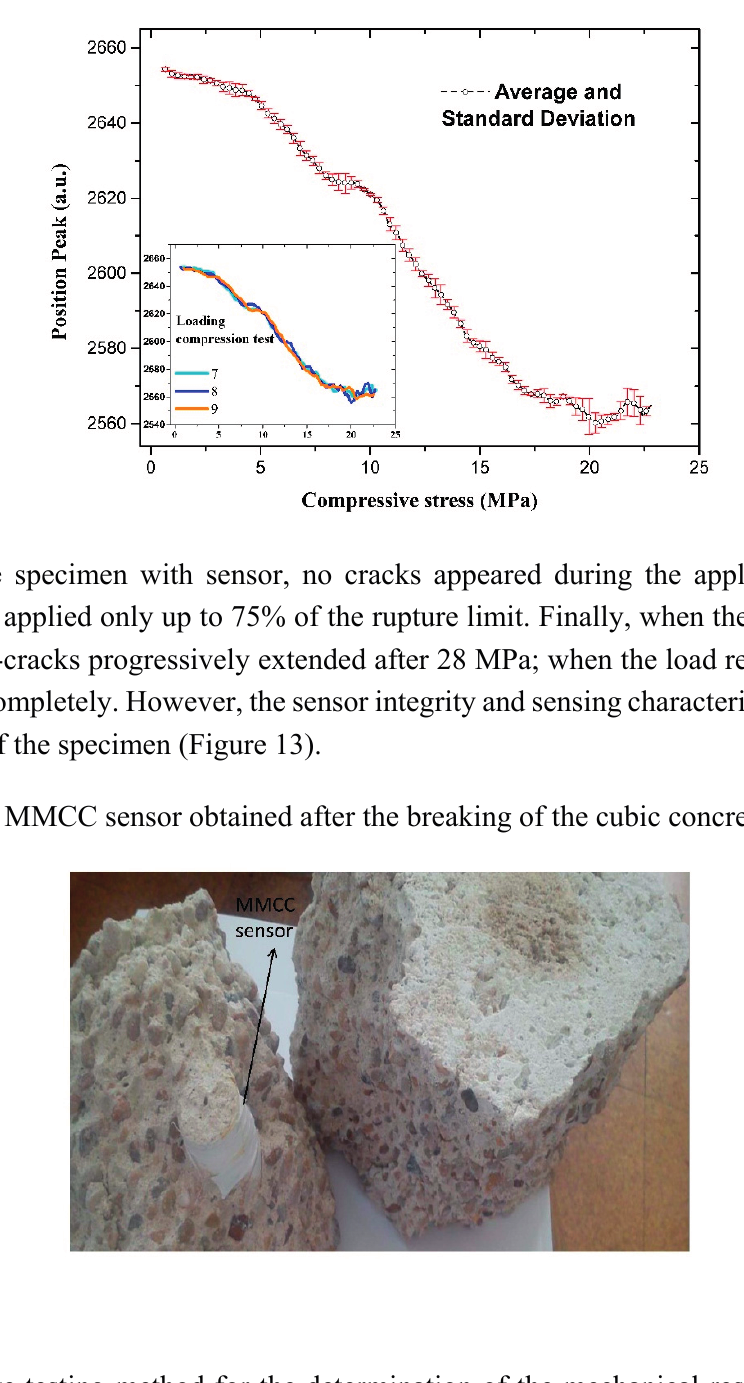
Figure 12. Averaged and standard deviation of the peak position.